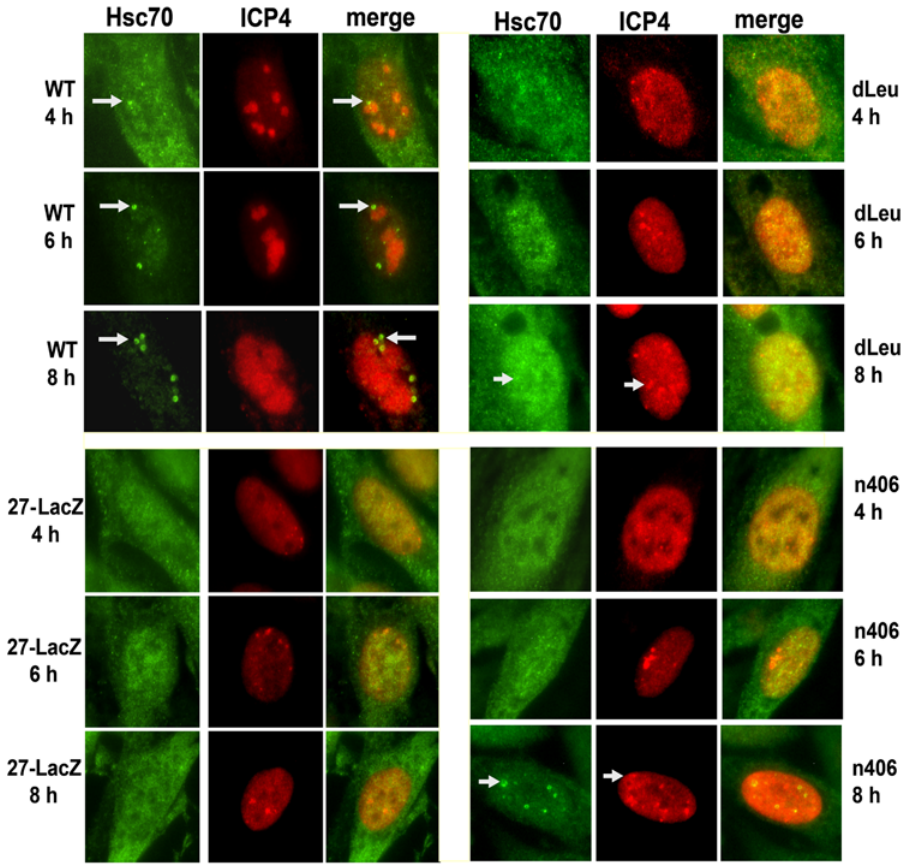
Figure 6. Hsc70 Focus Formation Correlates with HSV-1 Replication Compartment Formation. Vero cells were infected with WT HSV-1, 27-LacZ, dLeu or n406. At the times indicated, cells were fixed and stained with anti-Hsc70 and anti-ICP4 antibodies. Arrows point to Hsc70 foci (green) or pre- replication sites (red). (Figure 5), and a resultant delay in RNAP II degradation [11]. Therefore, the appearance of Hsc70 nuclear foci at the periphery of viral transcription/replication sites may occur as a result of the ubiquitination of RNAP II on stalled elongating complexes in high traffic areas of an actively replicating viral genome.